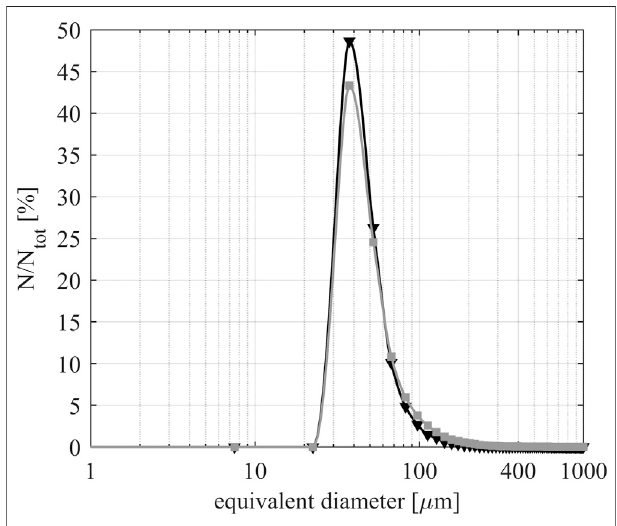
FIGURE 4 | Probability density functions of the pore space of composites A30% (black) and B30% (gray).